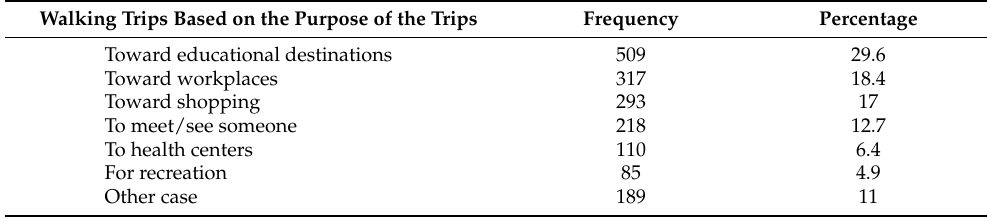
Table 2. Frequency of walking trips according to each type of destination in Temuco (N =